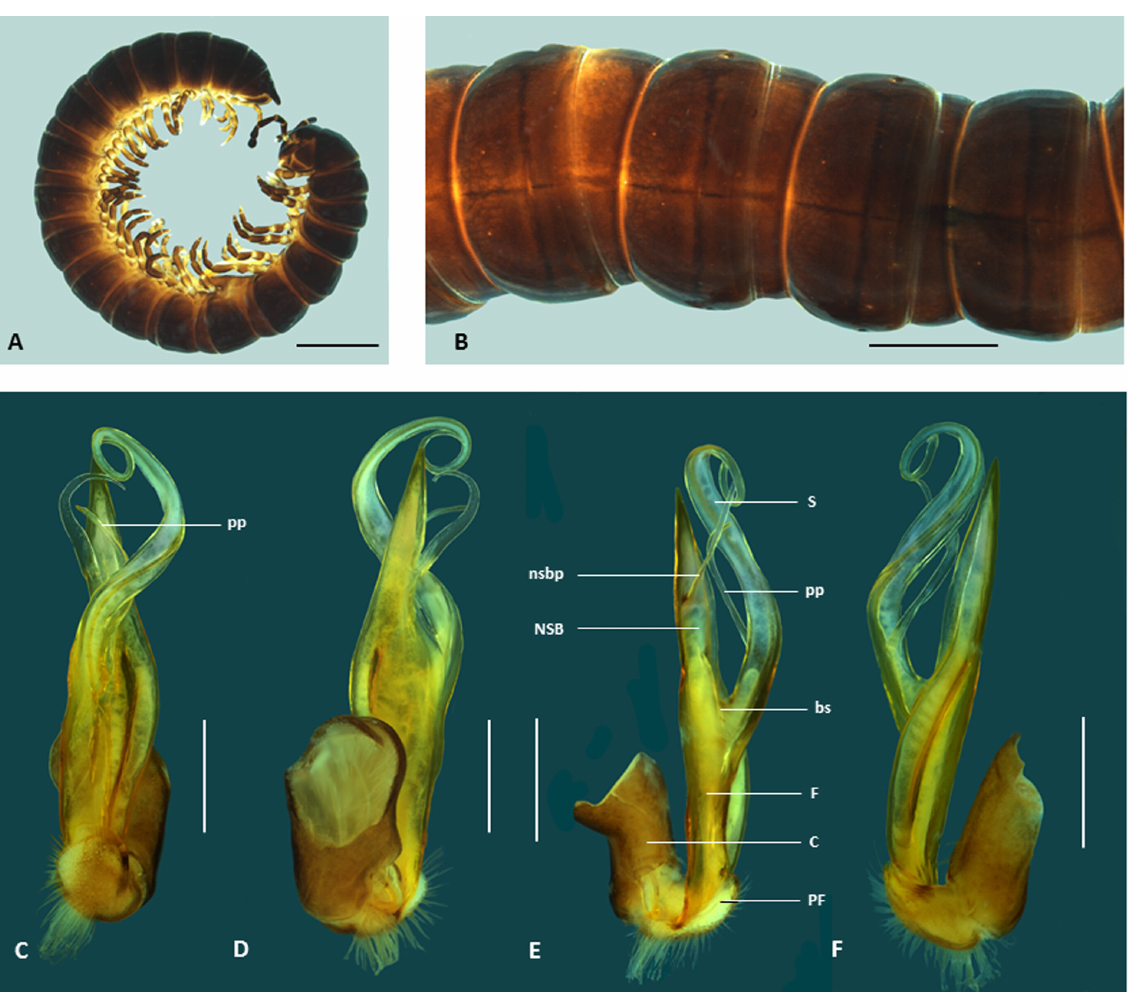
Fig. 2. Boreohesperus alcyonis sp. nov., holotype, ♂ (WAM T108780). A . Habitus, lateral view. B . Habitus, dorsal view. C–F . Left gonopod. C . Posterior view. D . Anterior view. E . Medial view. F . Lateral view. Abbreviations: bs = solenomere base; C = coxa; F = femorite; NSB = non-seminiferous branch; nsbp = non-seminiferous branch process; PF = prefemur; pp = posterior process; S = solenomere. Scale bars: A = 2 mm; B = 1 mm; C–F =